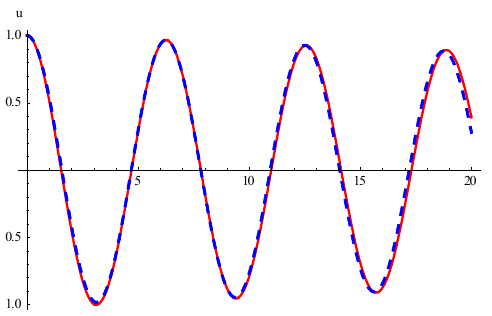
Figure 2. Comparison between the numerical solution of Equations (10) and (23) at simultaneous resonance and approximate solution (55) : ____ numerical integration solution; _ _ _ analytical solution.